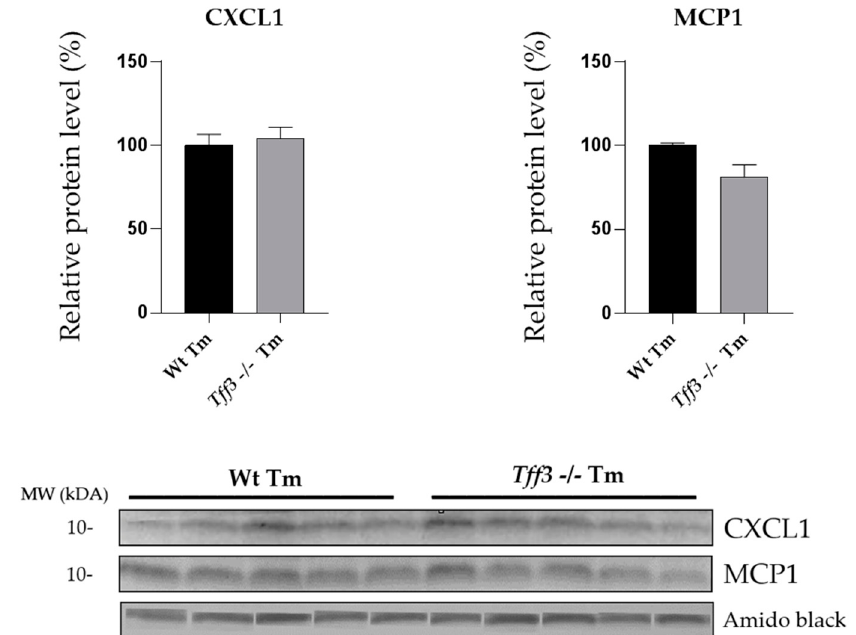
Figure 5. Effect of tunicamycin treatment on the expression of CXCL1 and MCP1 protein in Wt and Tff3 -deficient mice. Protein level of CXCL1 and MCP1 was determined by Western blot in liver homogenate of WT (C57BL6/N) and Tff3 − / − mice treated with tunicamycin. Protein level is presented relative to Wt mice as mean ± SEM of specific protein band density normalized with amido black. The differences between groups were compared by the Student t -test. Wt Tm = wild type tunicamycin- treated mice, Tff3 − / − Tm = Tff3 − / − tunicamycin-treated mice. Int. J. Mol. Sci. 2019 , 20 , x FOR PEER REVIEW